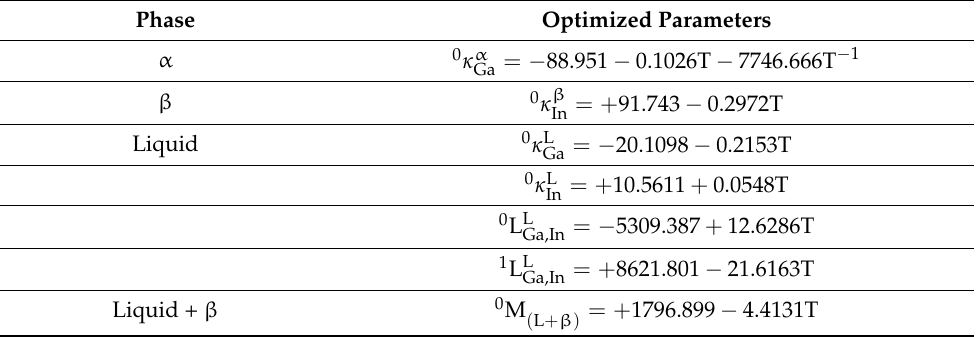
Table 2. Optimized thermal conductivity parameters for the individual phases and the two-phase regions in Ga-In system using the CALPHAD